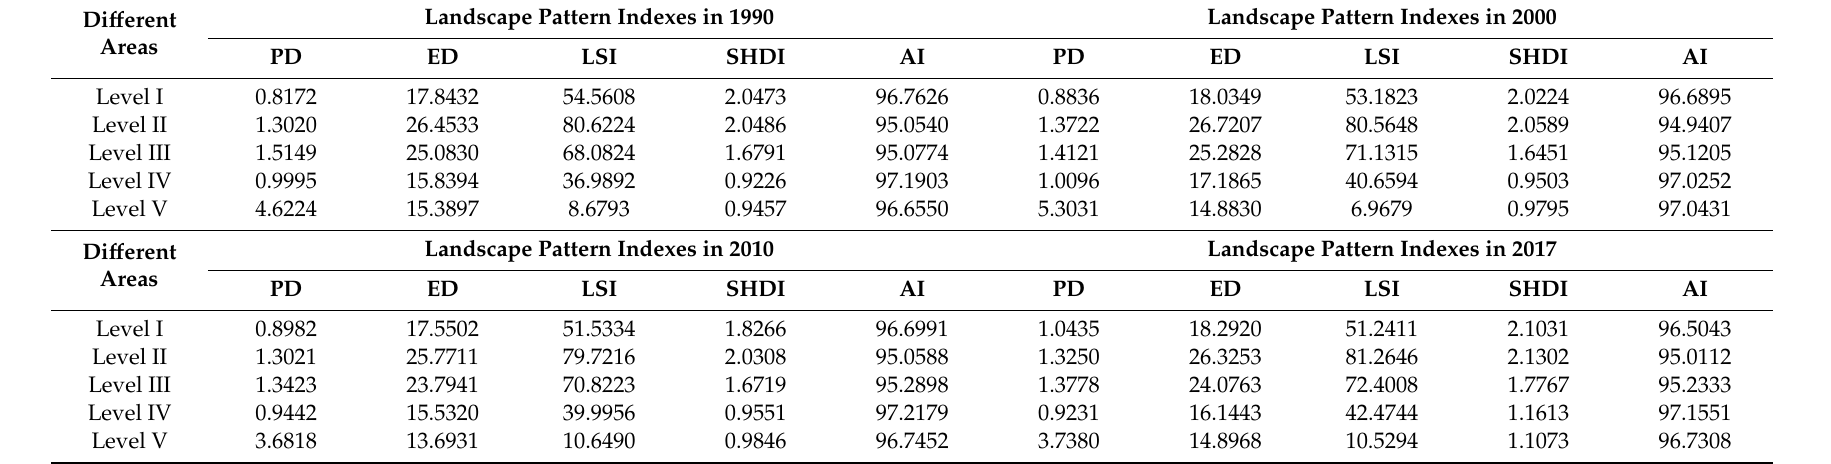
Table A3. Landscape pattern indexes at areas with di ff erent levels of